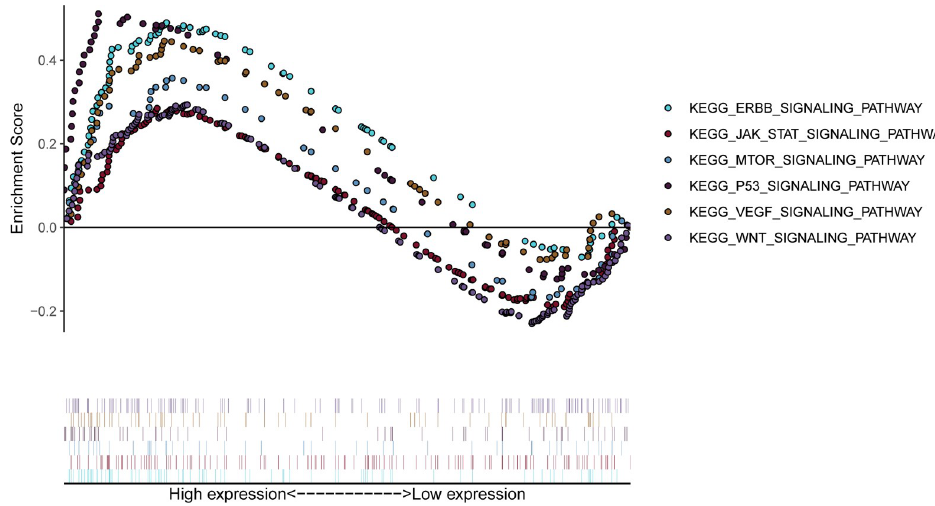
Fig 9. GSEA analysis showed the KEGG signaling pathway in breast cancer patients with high expression of RRM2.